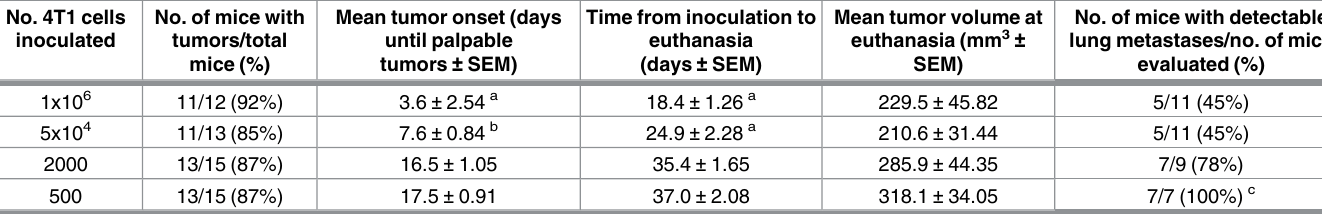
Table 1. Tumor growth and metastasesin 4T1 breast carcinoma-bearing mice. No. 4T1 cells